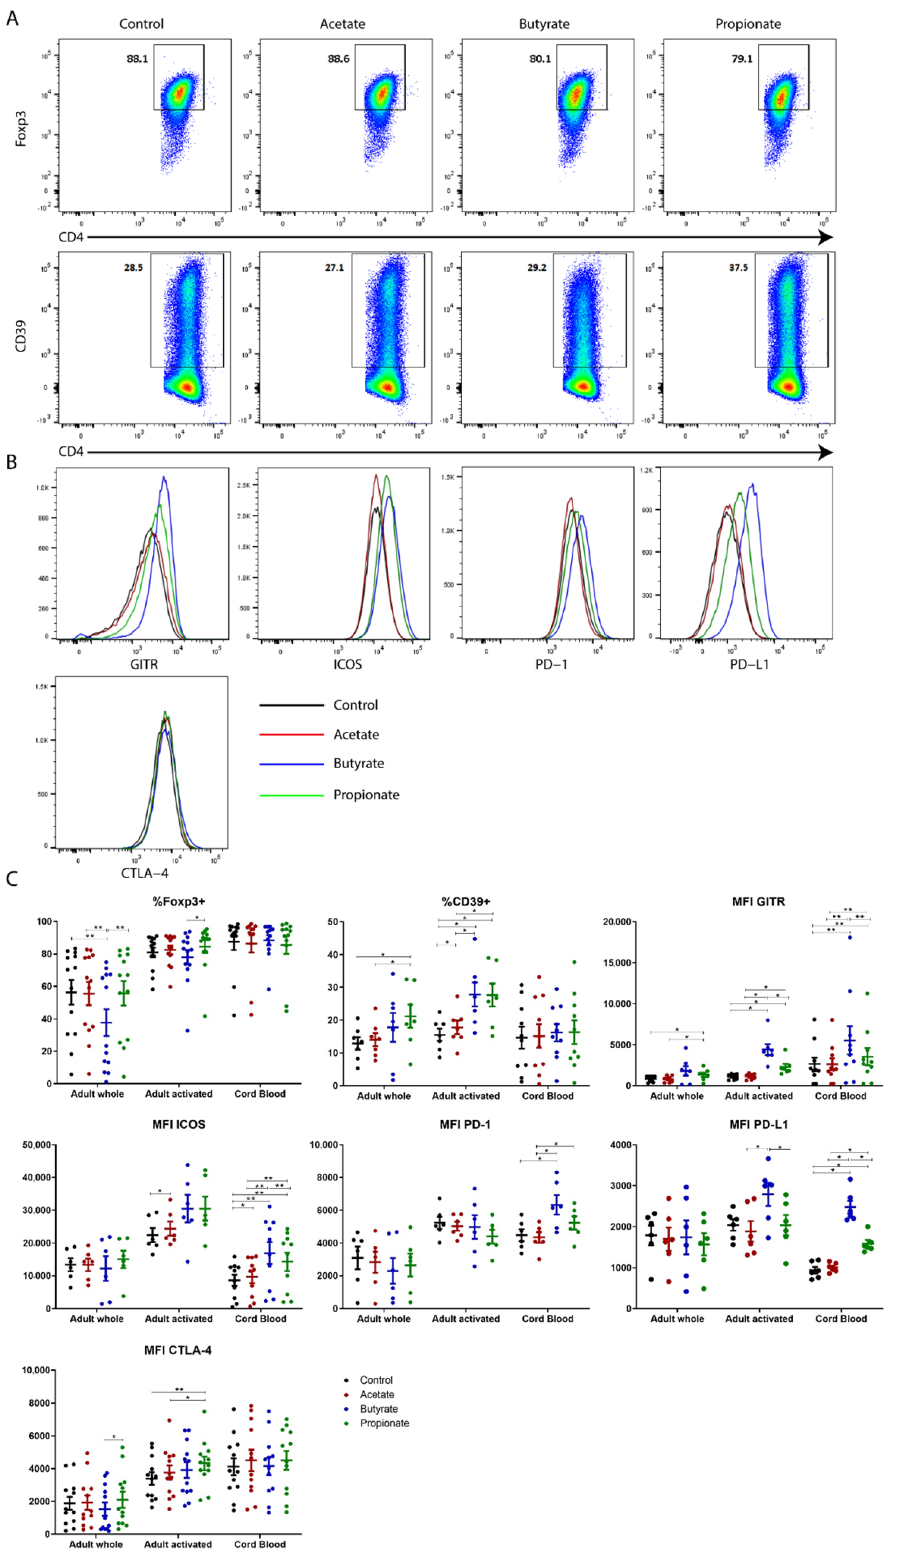
Figure 4. Short-chain fatty acids (SCFAs) potentiate the generation of human transforming growth factor β (TGF- β )-induced Tregs in vitro. ( A ) Representative dot plots gated on live CD4 + CD3 + T cells showing the percentage of Foxp3 + (upper panel) and CD39 + (lower panel) cells induced after culturing under various conditions: control (interleukin-2 (IL-2) + TGF- β ), acetate (IL-2 + TGF- β + acetate),